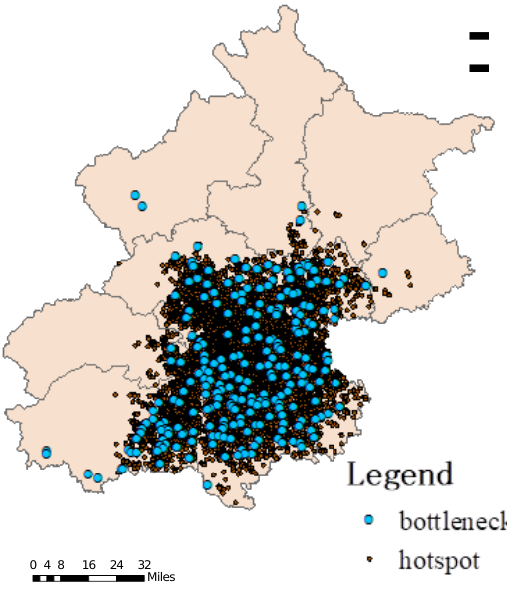
Figure 6. The top 155 analysis regions with the largest